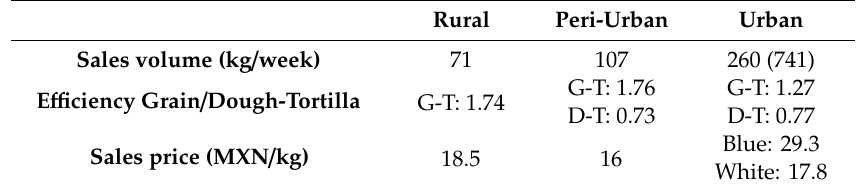
Table 4. Average values associated with the sale of tortillas in urban, peri-urban, and rural HCTE. Rural Peri-Urban Urban Sales volume (kg / week) 71 107 260 (741) G-T: 1.76 G-T: 1.27 E ffi ciency Grain / Dough-Tortilla G-T: 1.74 D-T: 0.73 D-T: 0.77 Blue: 29.3 Sales price (MXN / kg) 18.5 16 White: